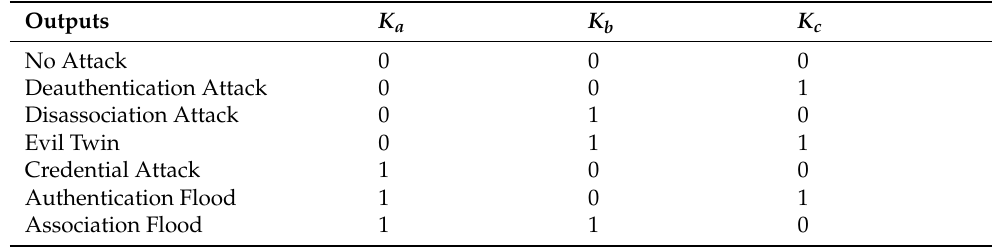
Table 3. State machine